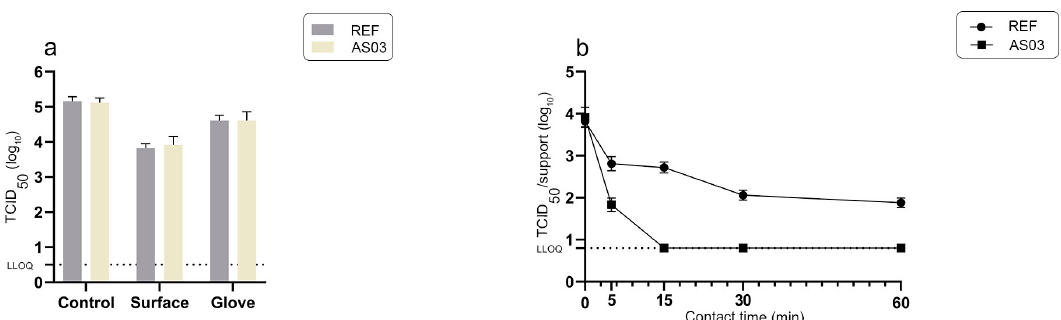
Figure 5. ( a ): Amount of infectious murine norovirus at T0 transferred from the artificially contaminated gloved fingertip to stainless steel supports (REF) and AS03 active surface (surface); residual quantities of virus on gloved fingertip after the viral transfer (glove) and from direct washing of fingertips prior to transferring to the surfaces (control). Mean values ± SD corresponding to 10 independent viral transfers for each surface. ( b ): Survival of murine norovirus on stainless steel supports (REF) and AS03 active surface after finger-pad viral transfer. LLOQ: lower limit of quantification (LLOQ = 0.8 log 10 TCID 50 ). Mean values ± SD corresponding to 10 inoculated supports for each time point.